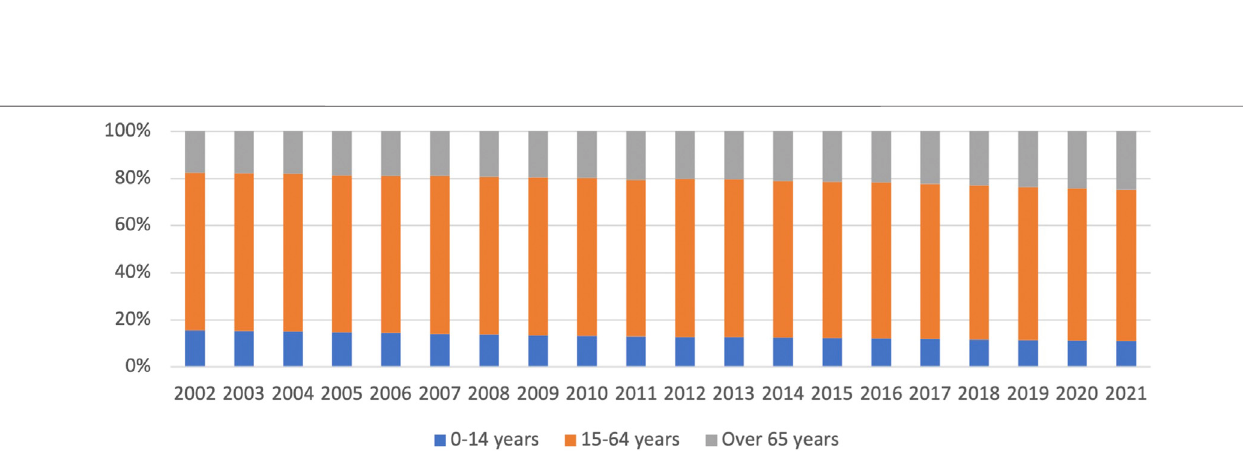
Frontiers in Robotics and AI |